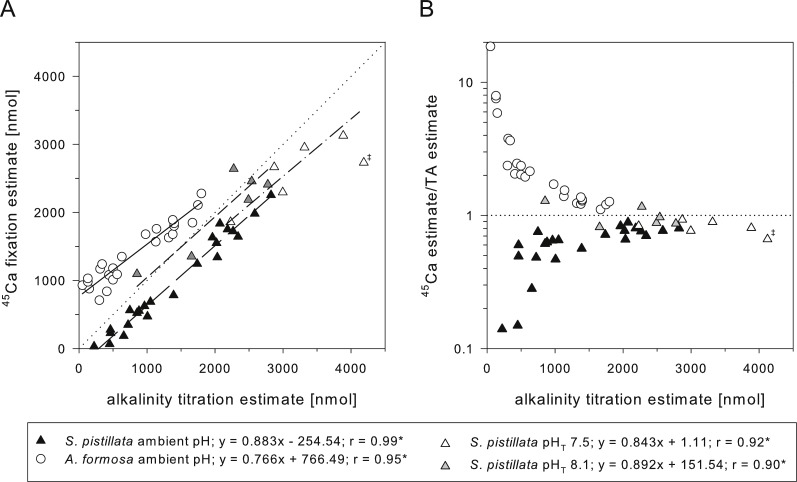
TA vs 45Ca calcification estimates.Relationship between calcification estimates based on TA titration and 45Ca fixation for Stylophora pistillata (triangles; white and grey this study, black from Tambutté et al., 1995) and Acropora formosa (circle, Smith & Kinsey, 1978). (A) Geometric regressions and pairwise correlations are indicated for all datasets (Table S1) based on Smith & Kinsey (1978) (solid; after 30 min of incubation with A. formosa), Tambutté et al. (1995) (long dash 0.25–3 h incubation with S. pistillata) and this study (short dash after 2 h with S. pistillata pHT 8.1, dash-dot pHT 7.5). (B) Agreement of both methods in relation to absolute calcification value (here based on TA). Data points show ratios of values shown in 3A. Statistical significance of pairwise correlations indicated by asterisks. Double dagger indicates excluded replicate point in the pHT 7.5 data set. Note that it is assumed that Smith & Kinsey (1978) and Tambutté et al. (1995) used blank-corrected calcification estimates.